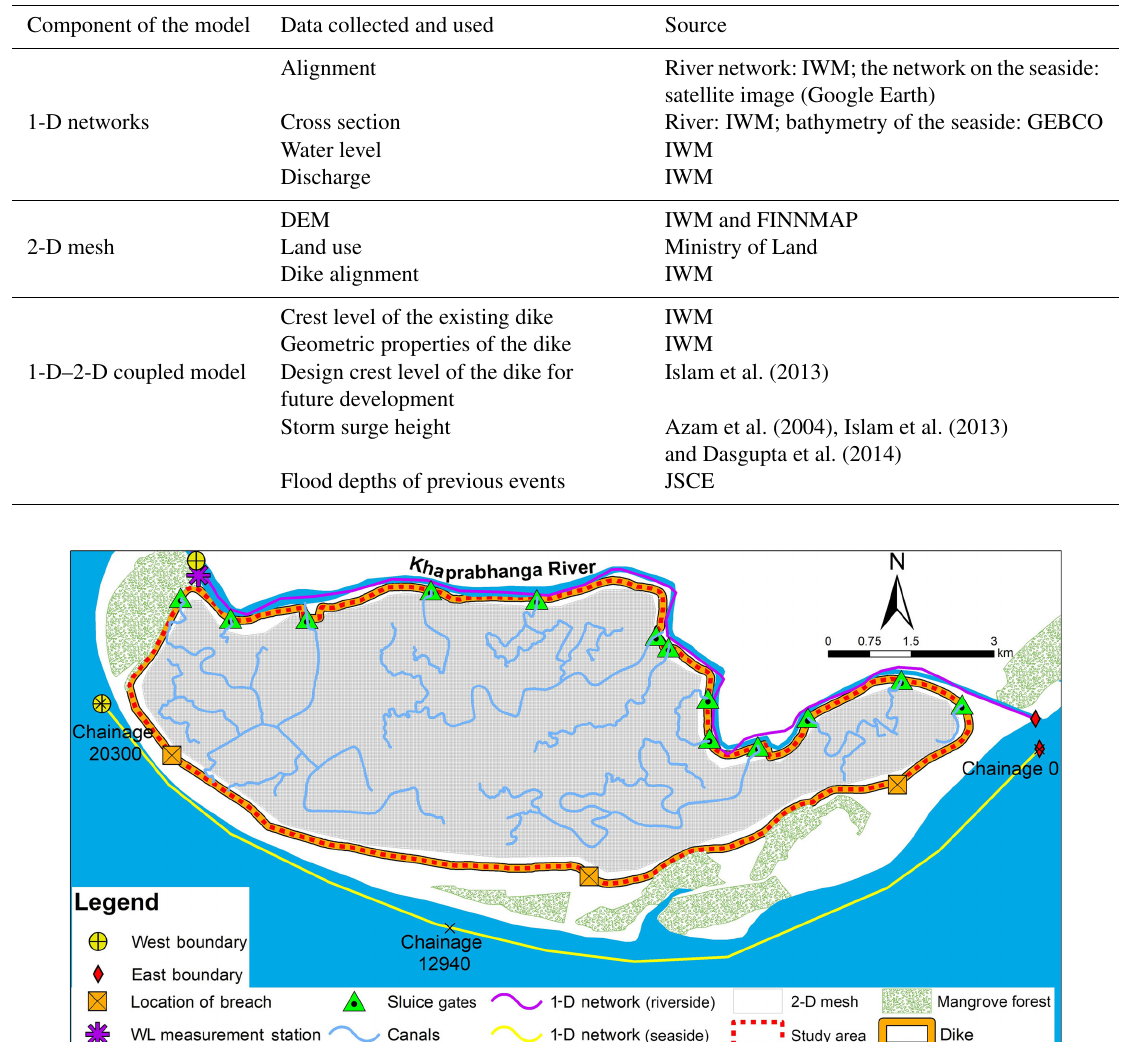
Table 1. The data used in developing the mathematical model and their sources. IWM, GEBCO and JSCE stand for the Institute for Water Modelling, the General Bathymetric Chart of the Oceans and the Japan Society of Civil Engineers respectively. Component of the model